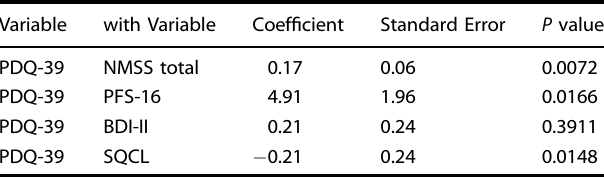
depression inventory-II, SQCL Scale of Quality of Life of